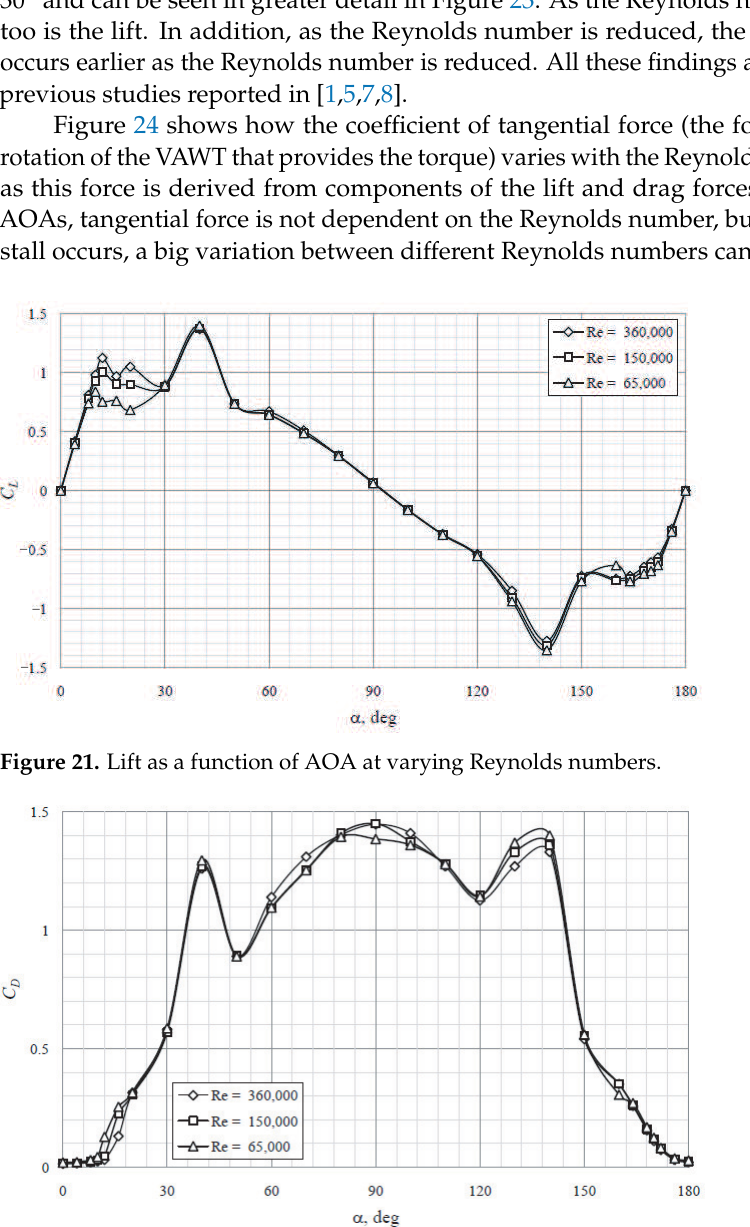
Figure 22. Drag as a function of AOA at varying Reynolds